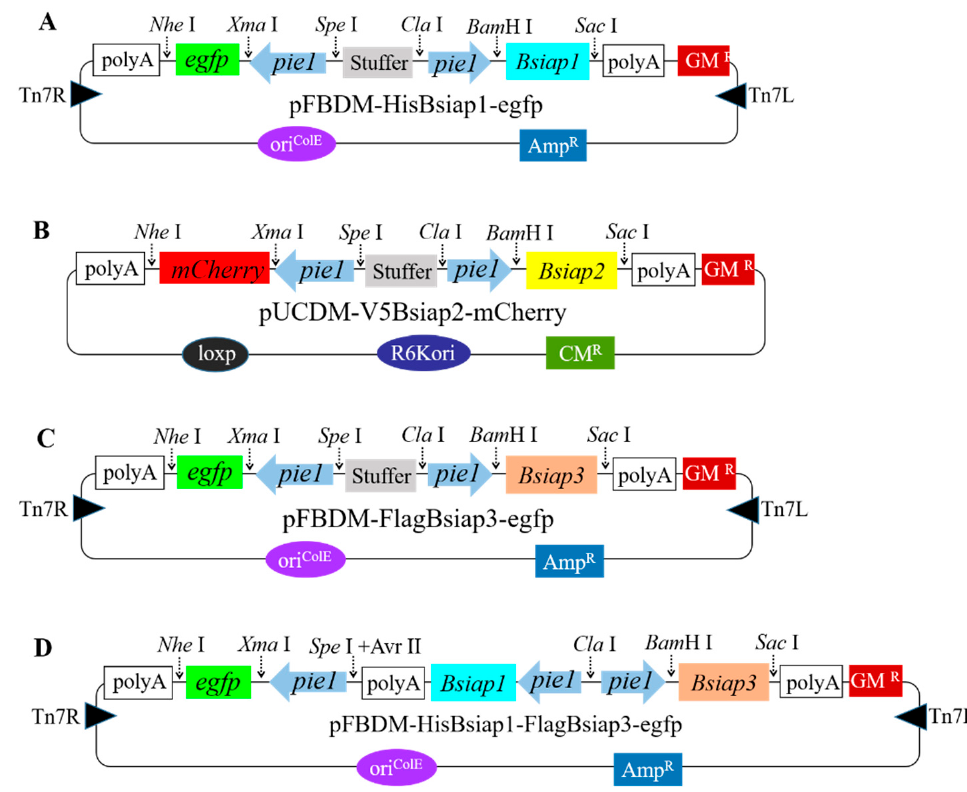
Figure 2. Construction of recombinant plasmids carrying Bsiaps and fluorescent genes. Maps of the pFBDM-HisBsiap1-egfp ( A ), pUCDM-V5Bsiap2-mCherry ( B ), pFBDM-FlagBsiap3-egfp ( C ), and pFBDM-HisBsiap1-FlagBsiap3-egfp plasmids ( D ).